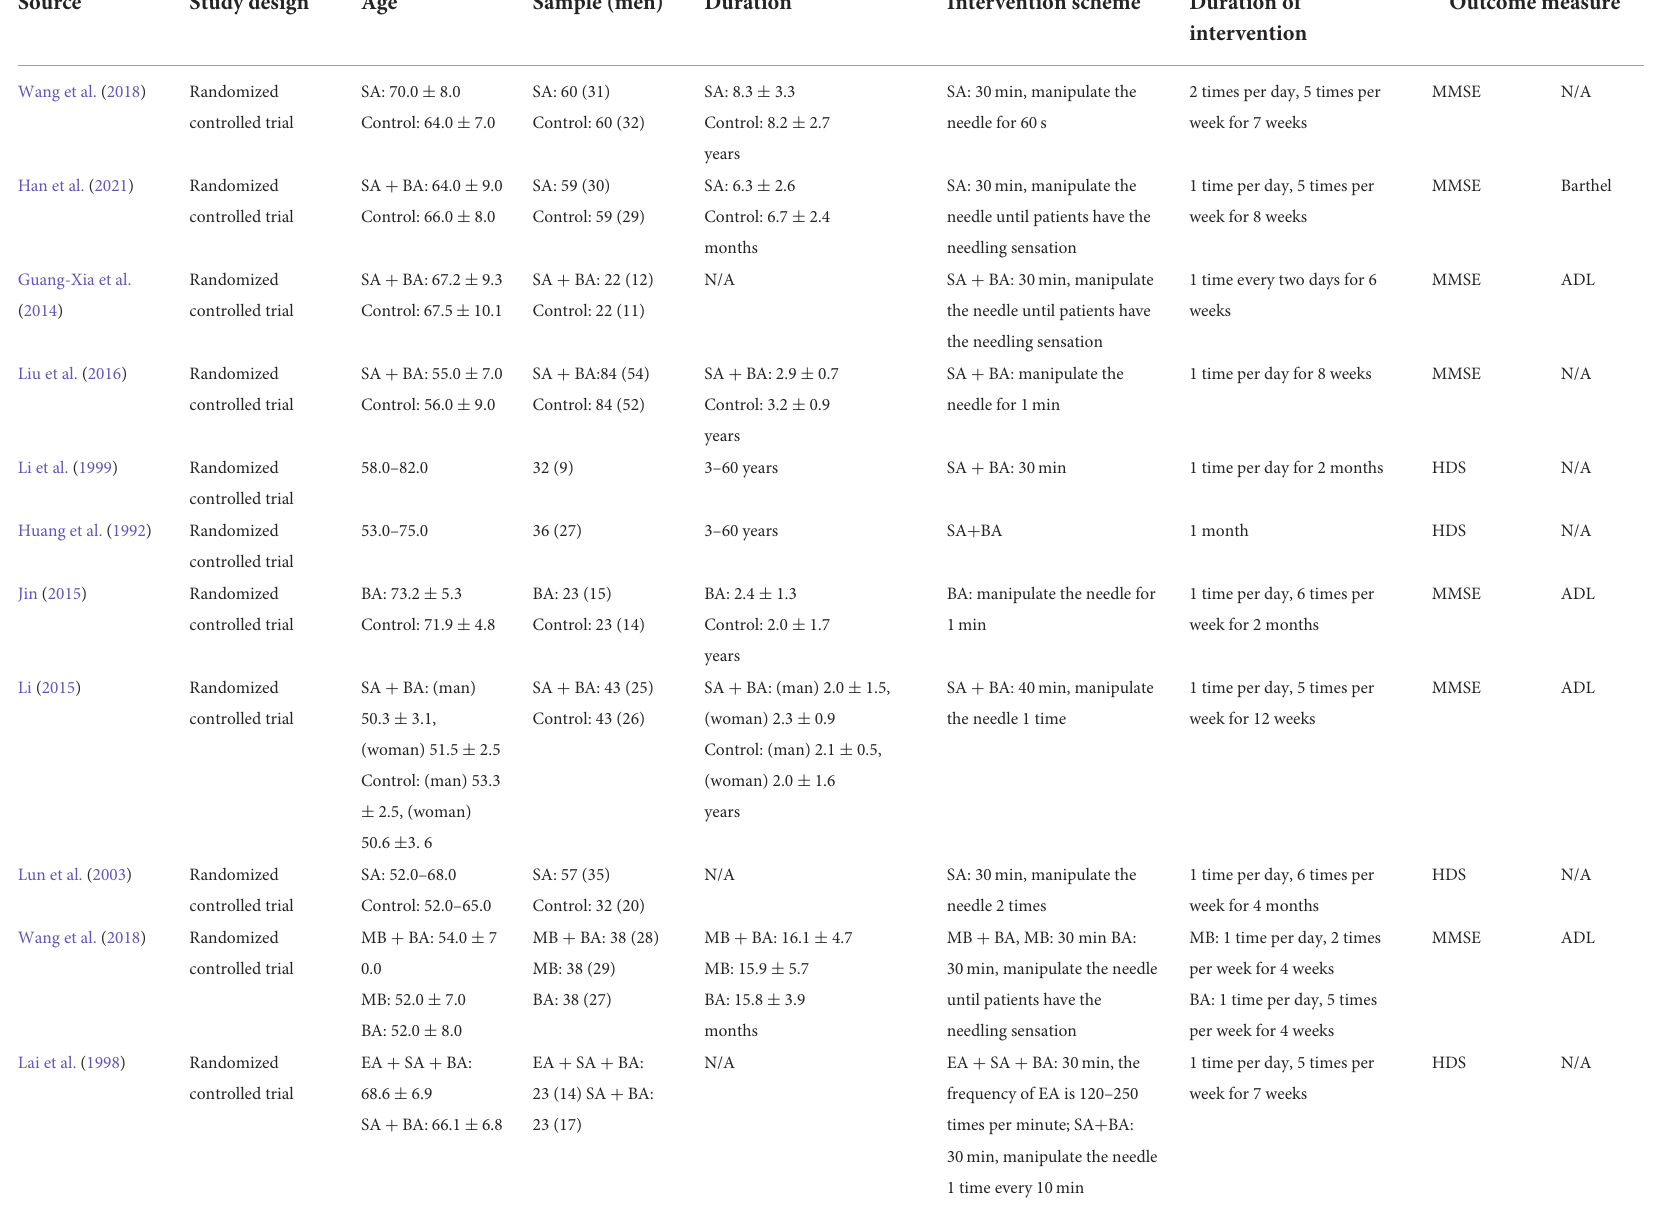
TABLE 1 The aggregated characteristics of the included